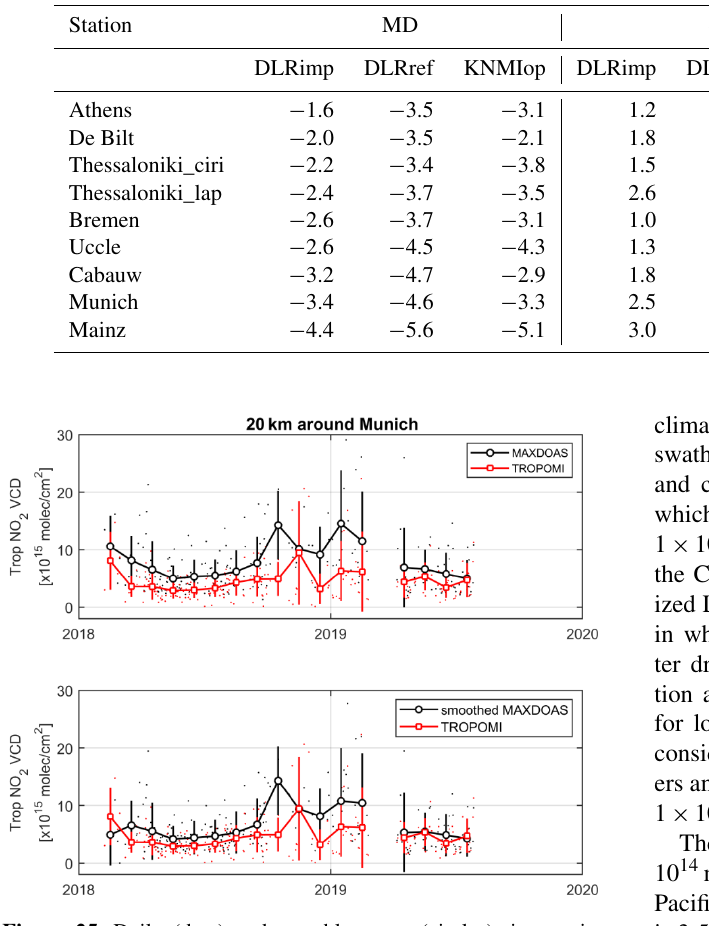
Figure 25. Daily (dots) and monthly mean (circles) time series of TROPOMI and MAX-DOAS tropospheric NO 2 columns for the Munich station. Results for the original comparisons and the smoothed comparisons are